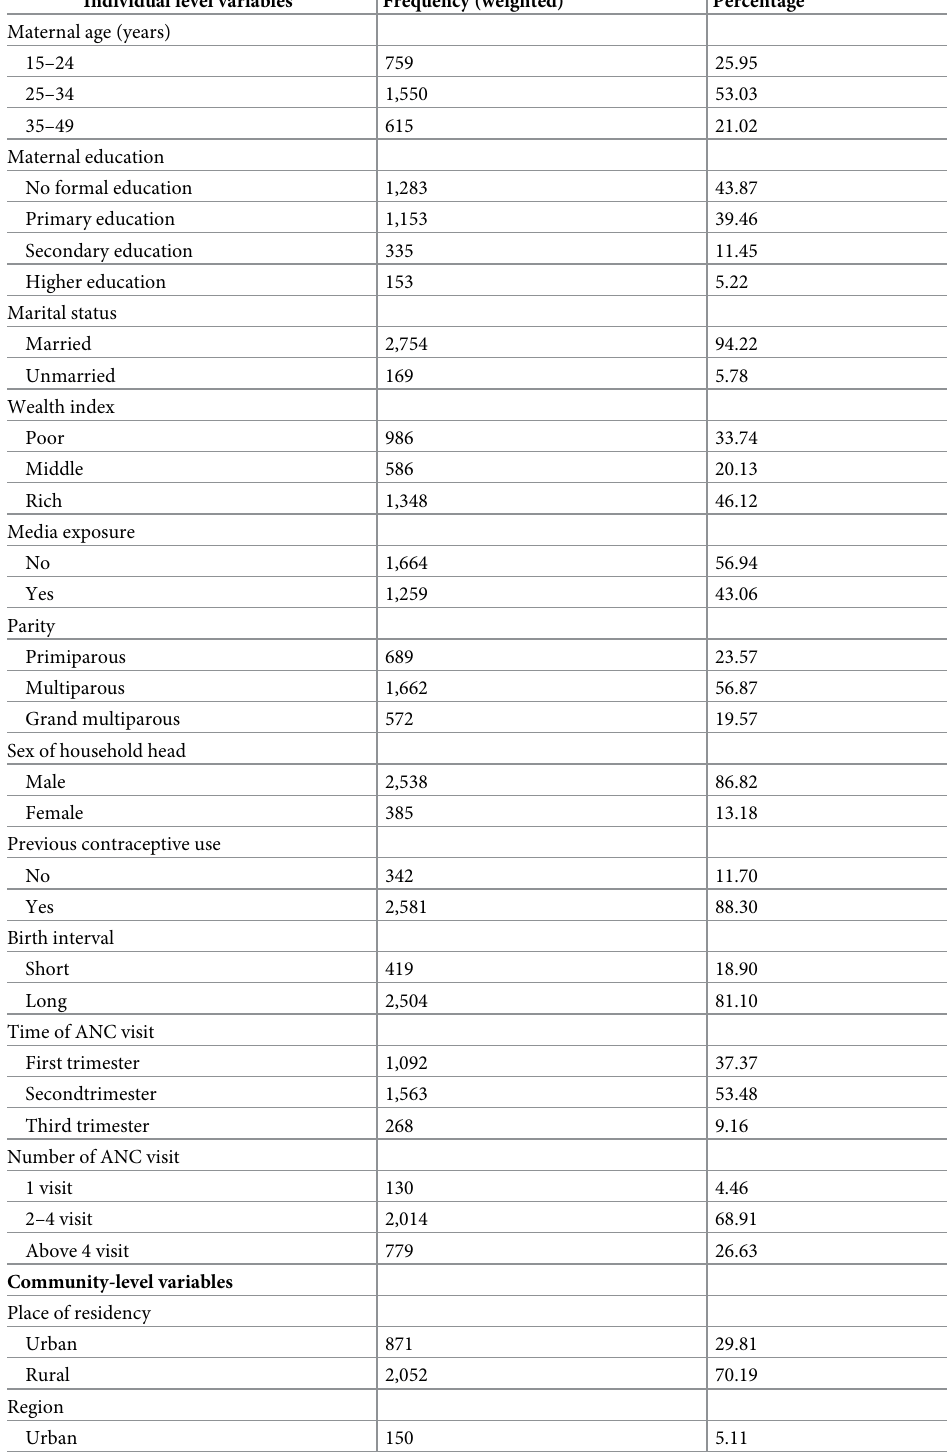
Table 1. Individual and community-level characteristics of study participants who had home delivery after ANC visit in Ethiopia, MEDHS 2019 (N =